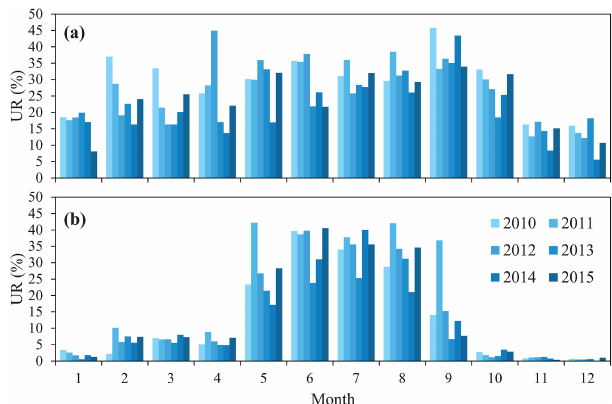
Figure 6. Monthly uncertainties in (a) temperate North America and (b) Europe.